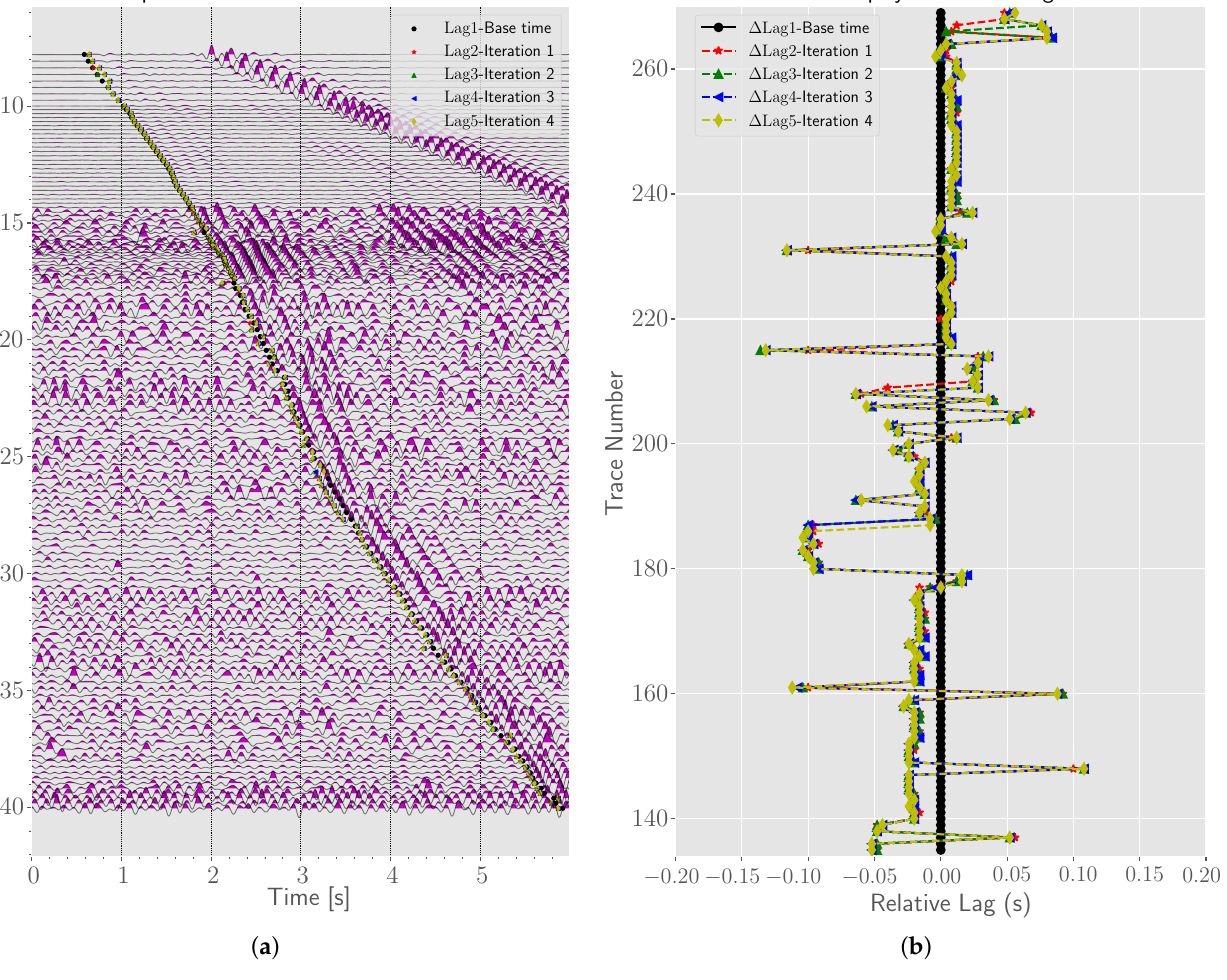
Figure 9. The results of first-arrival seismic phase identification using a hybrid method. ( a ) Auto- picked travel time points marked on 2D seismic section. ( b ) Magnified display of the differences between the results after four iterations and the base